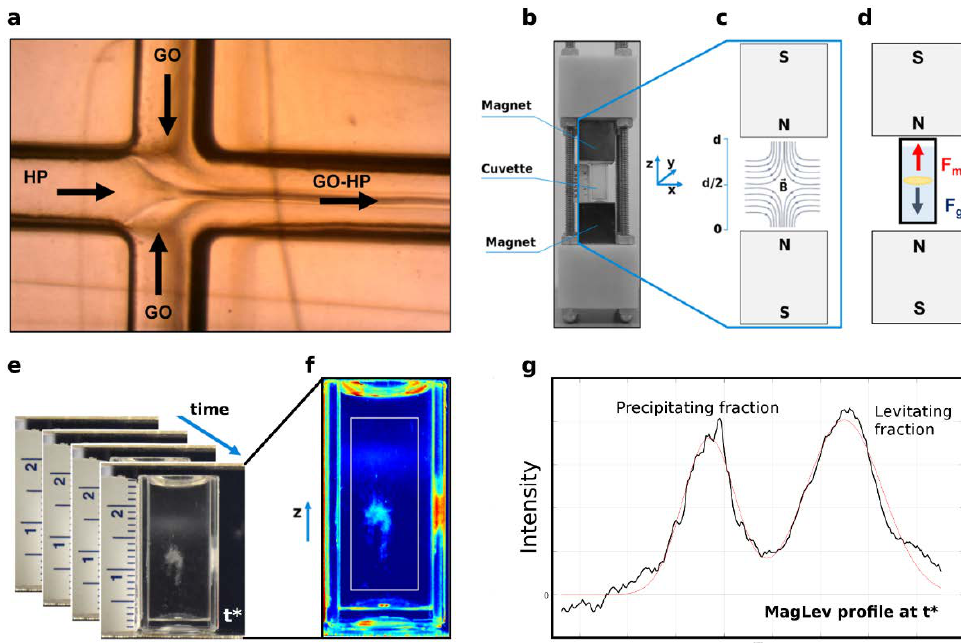
Figure 1. Representative workflow of the study: ( a ) GO-HP incubation within a microfluidic cartridge at controlled flow rates. Collected samples were inserted in ( b ) a MagLev device, responsible for a ( c ) magnetic field and thus a dynamic balance between ( d ) the acting forces, i.e., magnetic (F m ) and gravitational (F g ) force. Images of the samples were ( e ) acquired and ( f ) processed frame by frame to compute ( g ) the corresponding intensity profiles of the investigated samples (black lines). The profile was fitted by using a multipeak Gaussian distribution (red line). More details about image processing and the determination of the experimental error can be found in Figures S6 and S7 in the Supplementary